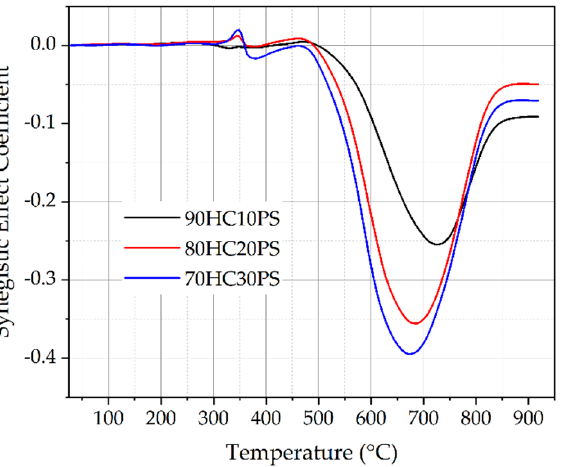
Figure 5. Degree of synergy towards TG curves for 90HC10PS, 80HC20PS, and 70HC30PS fuel samples at 12.5 °C/min heating rate under an air atmosphere.